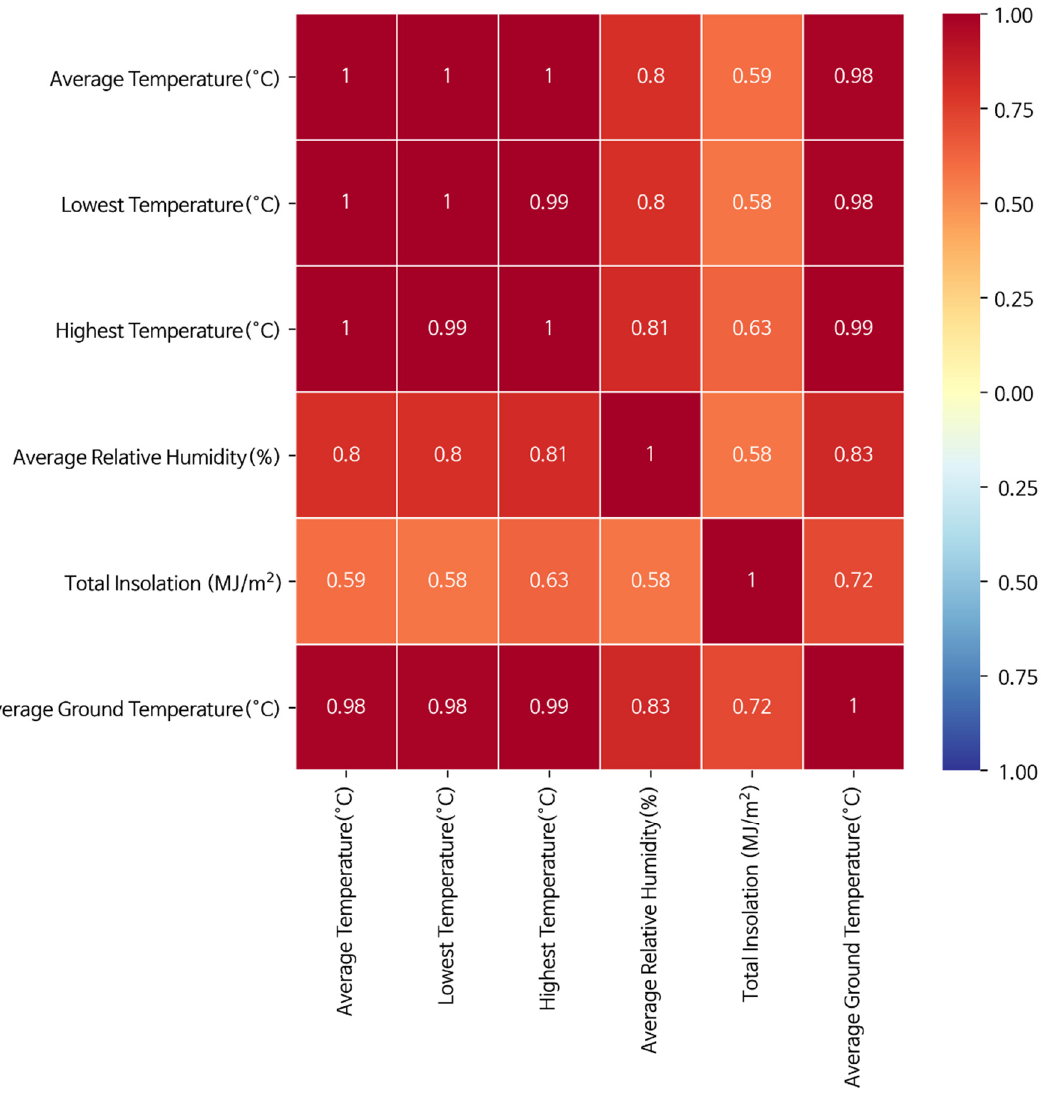
Figure 3. Pearson correlation coefficients. All values are significant ( p < 0.05).